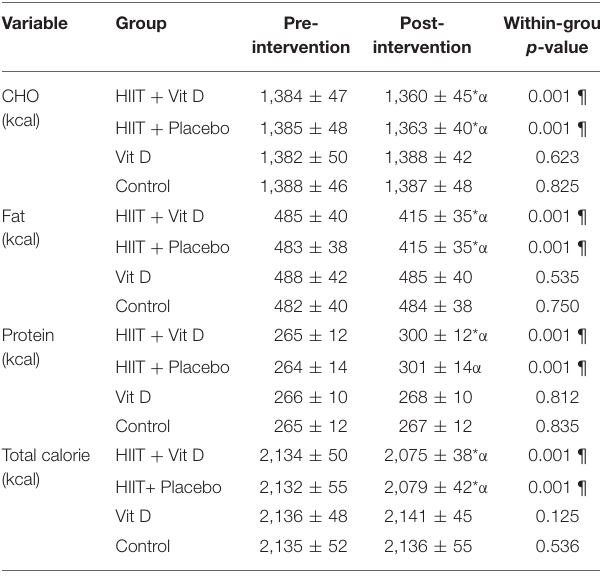
TABLE 1 | Demographic characteristics of the participants. Variable